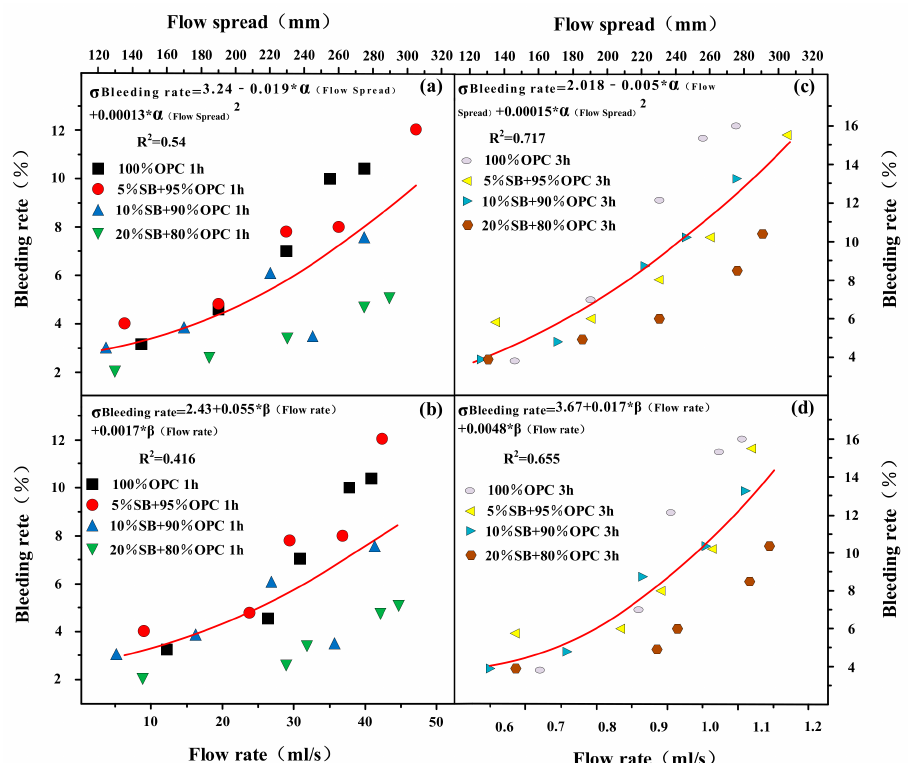
Figure 13. Flow rate and flow spread versus 1 h ( a,b ) and 3 h ( c,d ) bleeding rate.